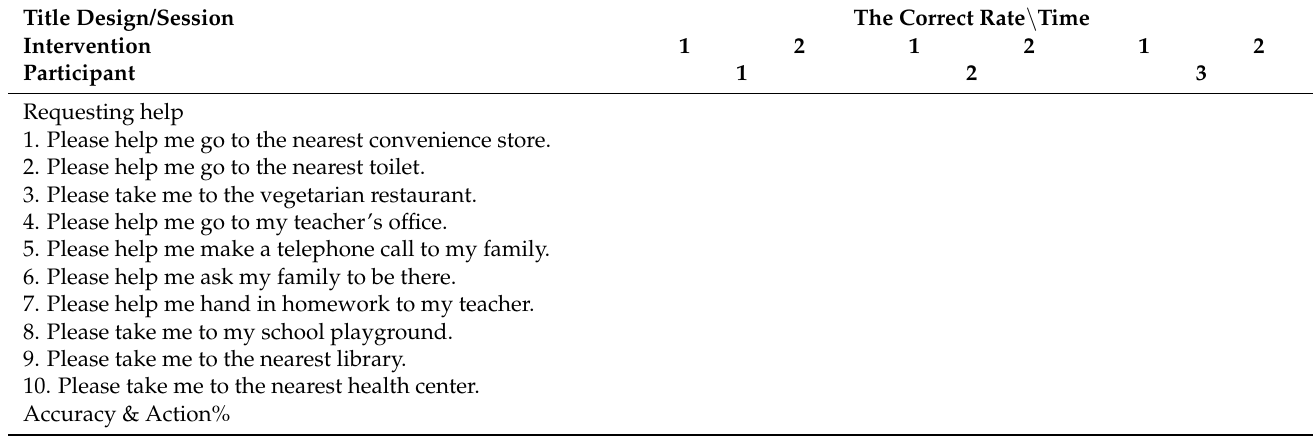
Table A1. Request help with experimental intervention record form